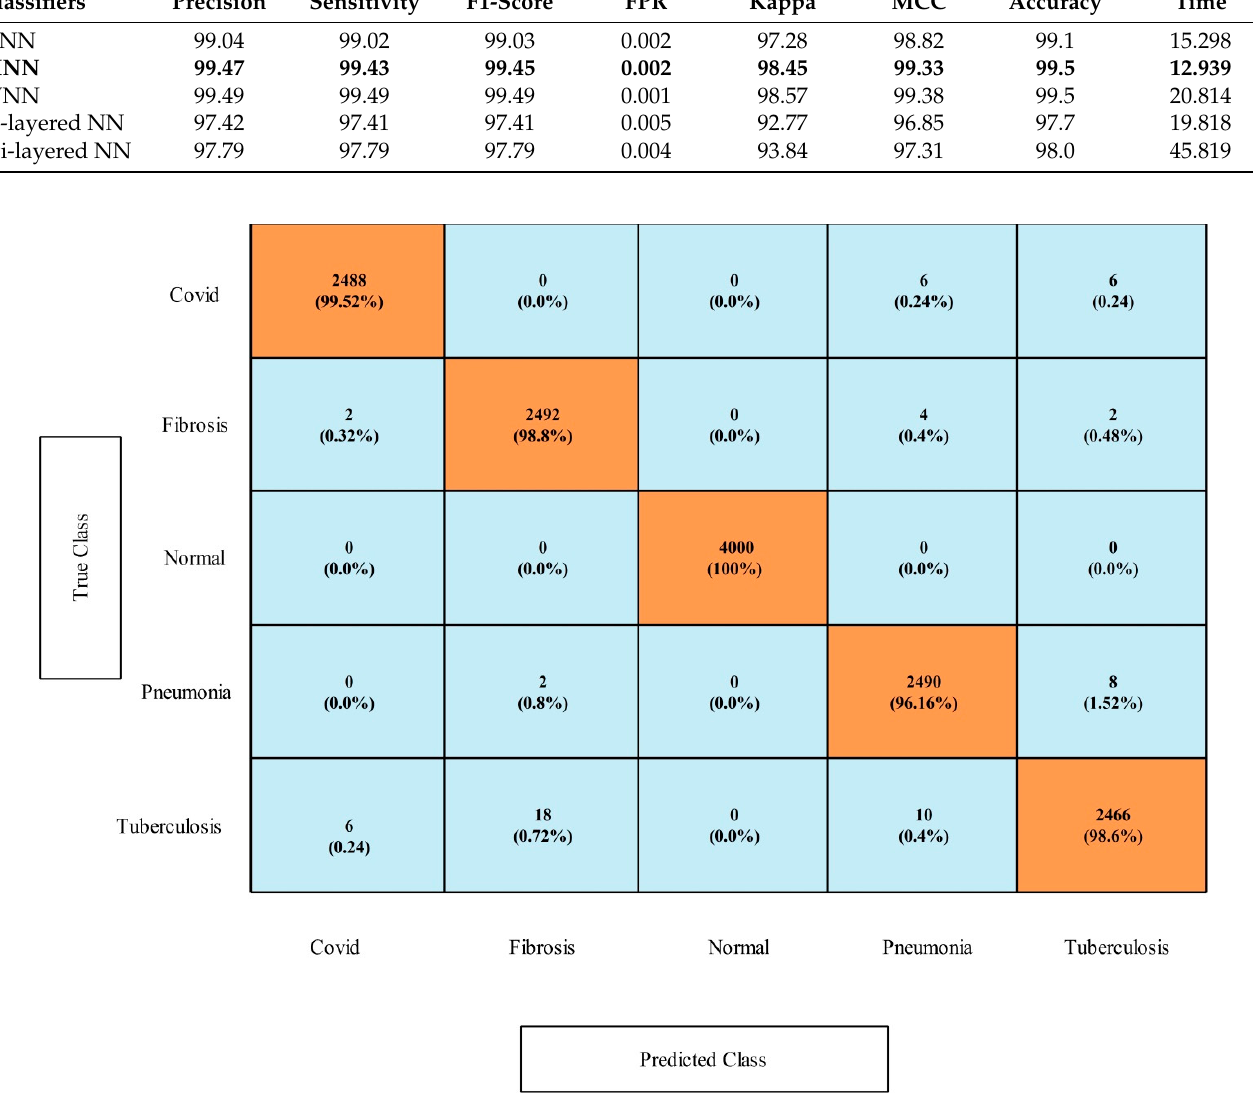
Figure 13. Proposed optimization approach confusion matrix of MNN classifier for COVID-19 Image dataset.